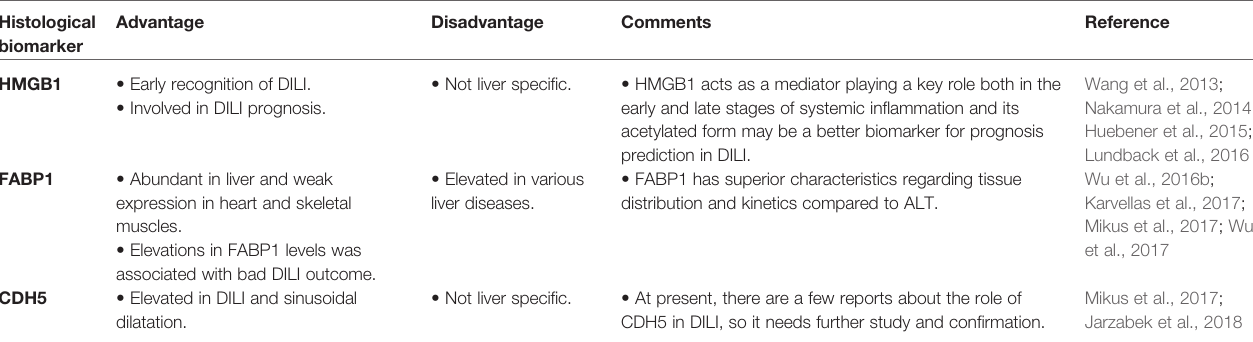
TABLE 3 | Histological Biomarkers of